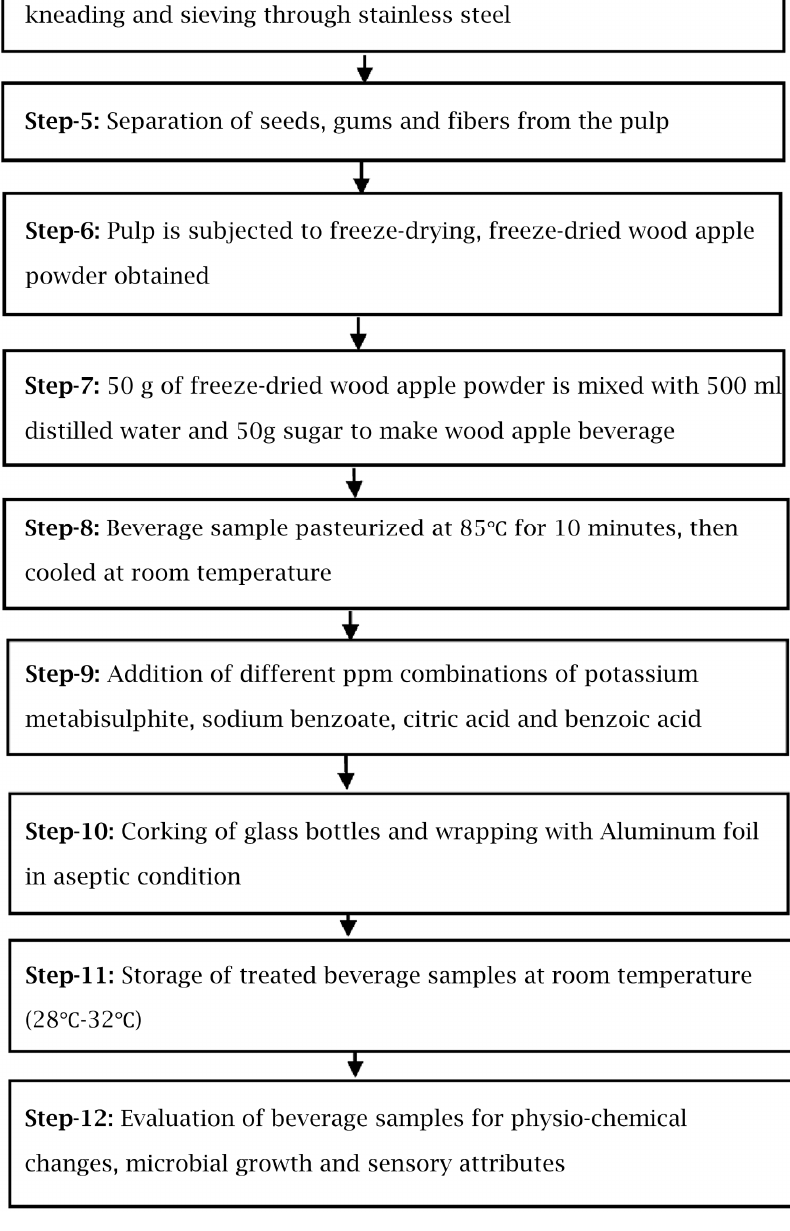
Figure 1. Flow chart showing procedure for preparing wood apple beverage